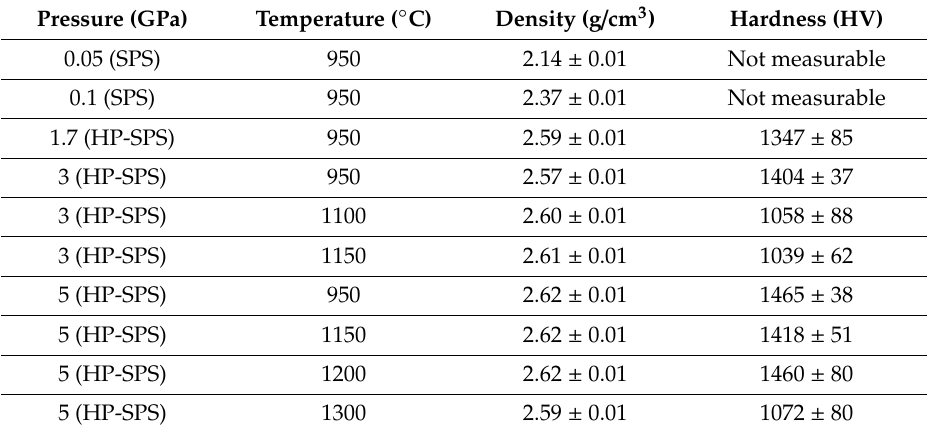
Table 2. Measurement of Vickers microhardness for sintered MgB 2